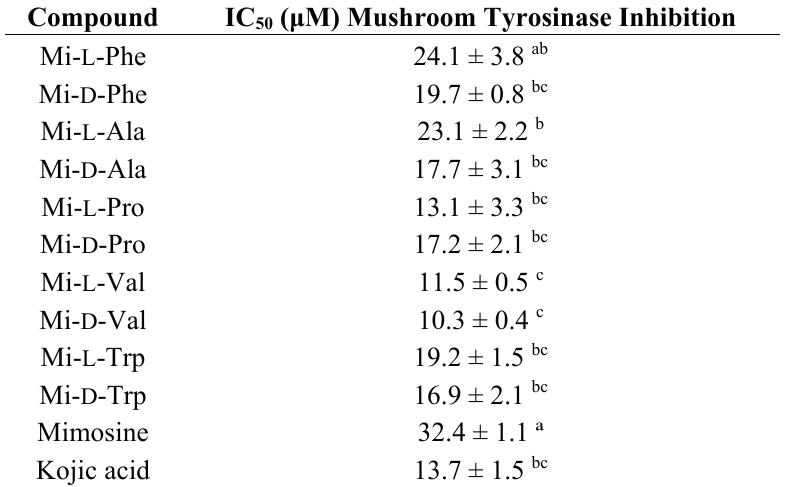
Table 1. IC 50 values of mimosine and their dipeptides for mushroom tyrosinase inhibition.